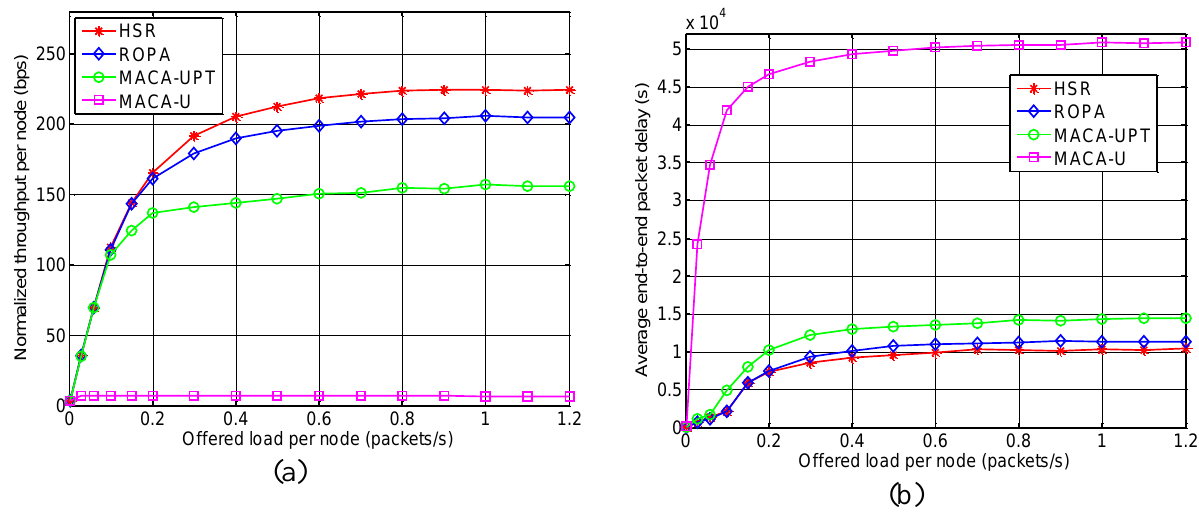
Figure 11. Performance comparison between HSR and other underwater MAC protocols: ( a ) Normalized throughput per node; and ( b ) Average end-to-end packet